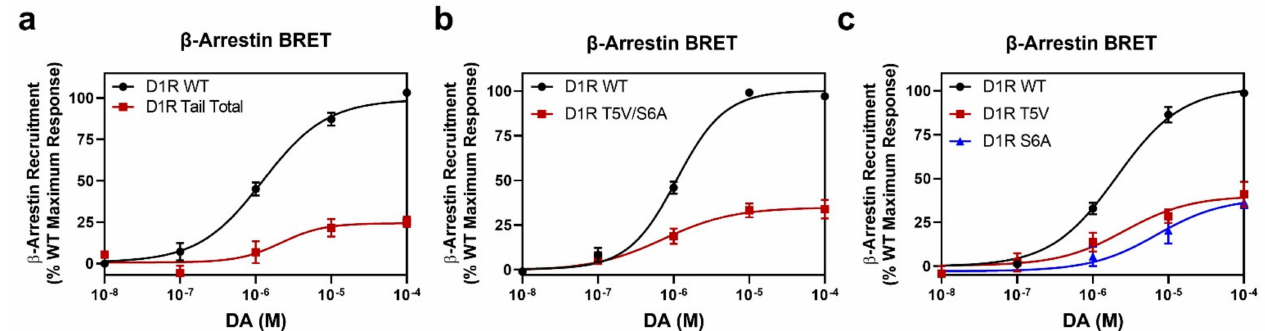
Figure 6. Orthogonal assays of β -arrestin recruitment confirm that mutation of all C-terminal phos- phorylation sites, or T5 and/or S6, severely diminishes β -arrestin recruitment. Direct D1R- β -arrestin BRET assays were performed as described in Section 4. Data are expressed as a percentage of the max- imum D1R WT response to DA stimulation in each experiment and are displayed as the mean ± SEM of at least three experiments, performed in triplicate. Statistical comparisons between the following D1R WT and mutant curve parameters were made using a one-way ANOVA with Dunnett’s post hoc comparison: ***** p < 0.0001. ( a ) In this direct β -arrestin recruitment assay, the D1R Tail Total mutant displays diminished DA-induced β -arrestin recruitment: D1R WT EC 50 = 1.3 ± 0.3 µ M, Emax = 100%; D1R Tail Total EC 50 = 4.0 ± 2.5 µ M, Emax = 25 ± 3.1% ****. ( b ) β -Arrestin recruitment is also